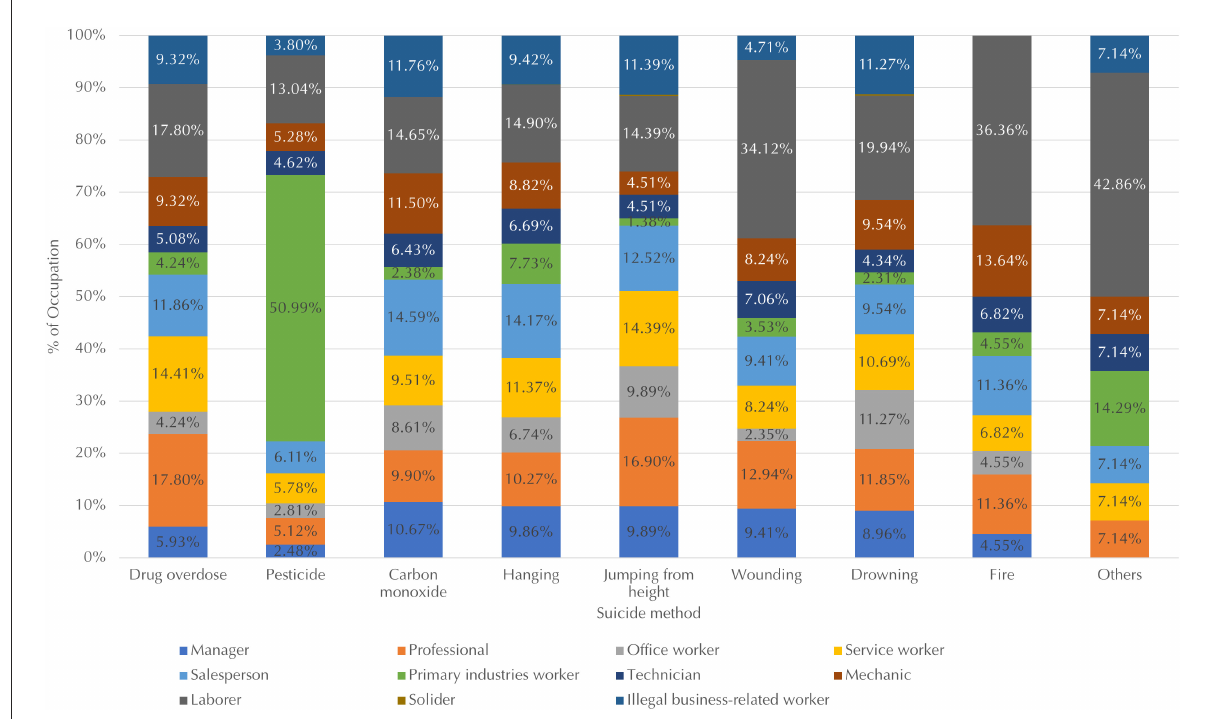
FIGURE5 Distribution of occupations across suicide methods, excluding firearm and transportation, which accounted for approximately 0.1% of the total suicide victims. Data for occupations that accounted for < 1% of victims for each suicide method, including soldiers, are not shown due to limited